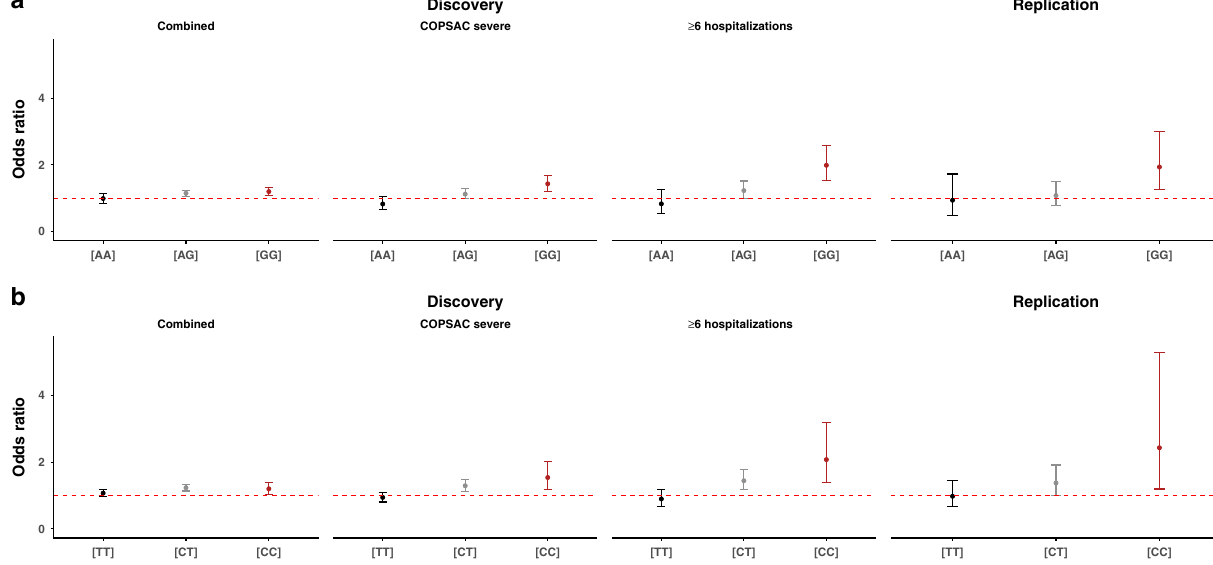
HR = 1.56, p = 0.002